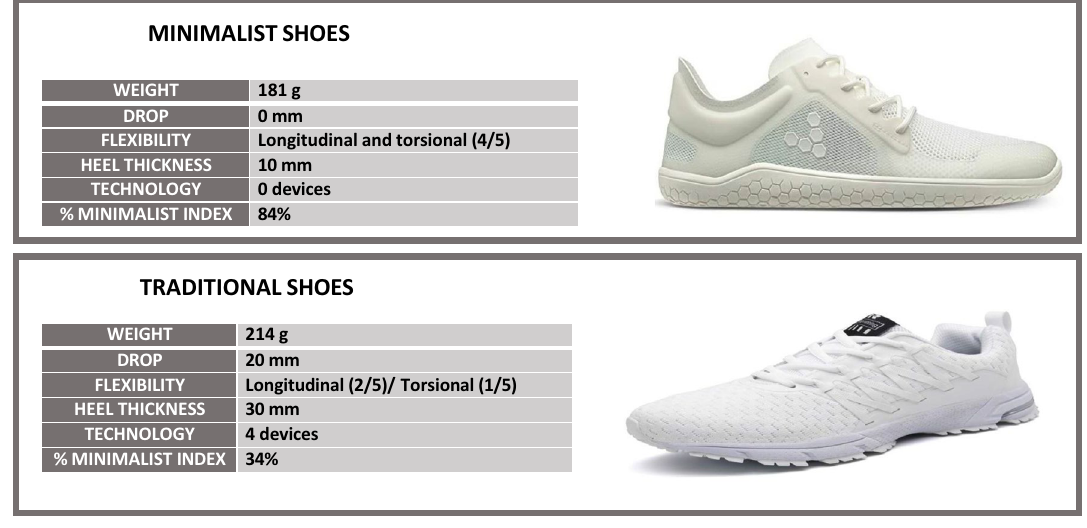
Figure 1. Minimalist and traditional shoe description.